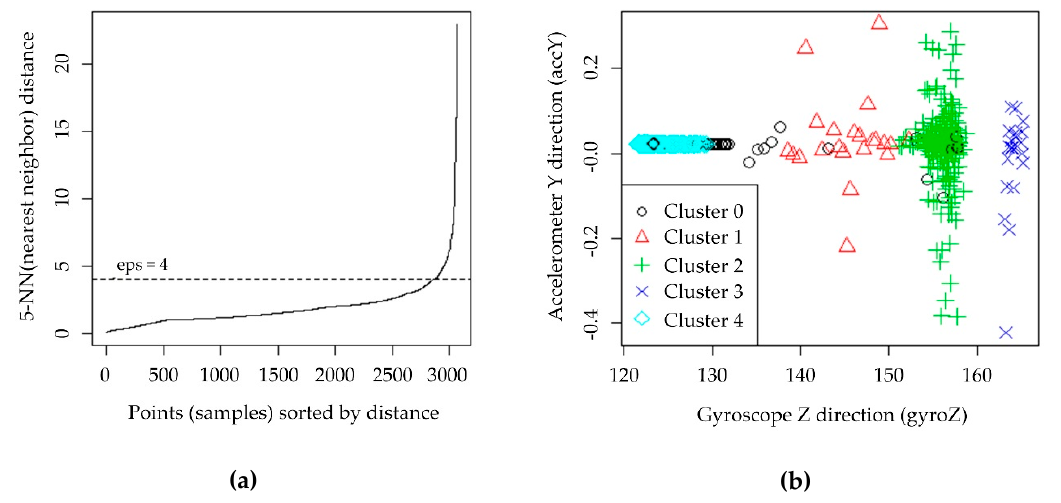
Figure 6. (a) Optimal value for eps using 5-NN (nearest neighbor) and (b) DBSCAN outlier